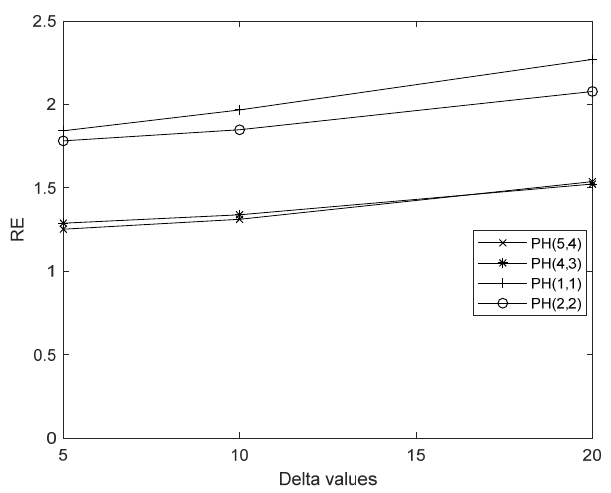
Fig. 10. Heuristic comparisions with respect to Delta